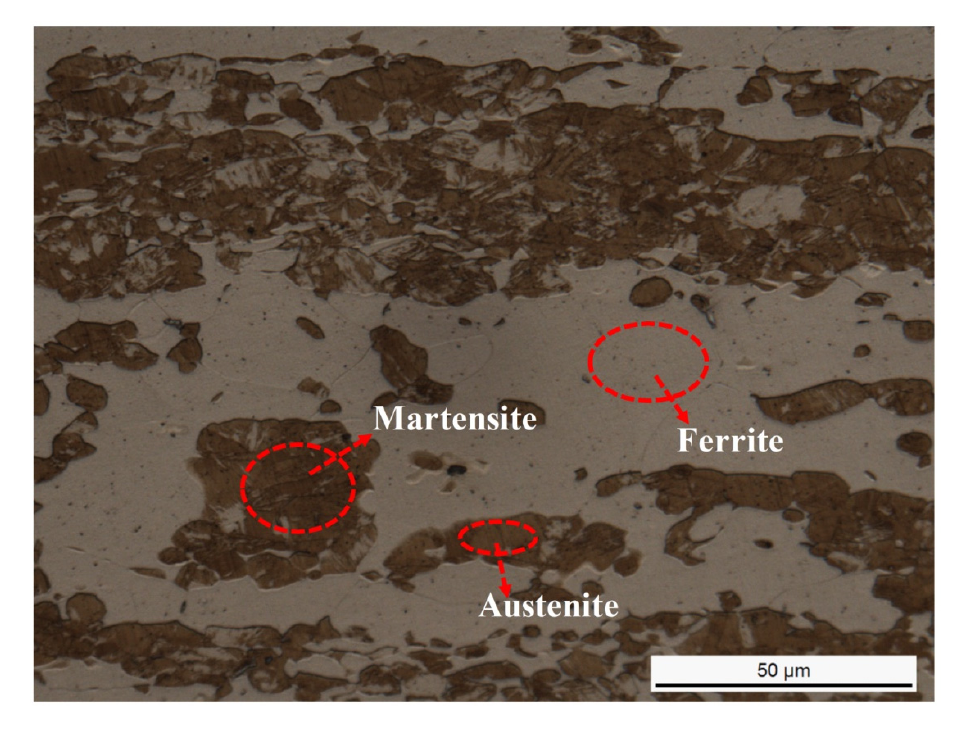
Figure 7. Optical micrographs of specimen annealed at 1050 °C for 30 min and pre-stretched to 40%, the dark area representing austenite while the light representing ferrite, and lath-shaped martensite was embedded in austenite